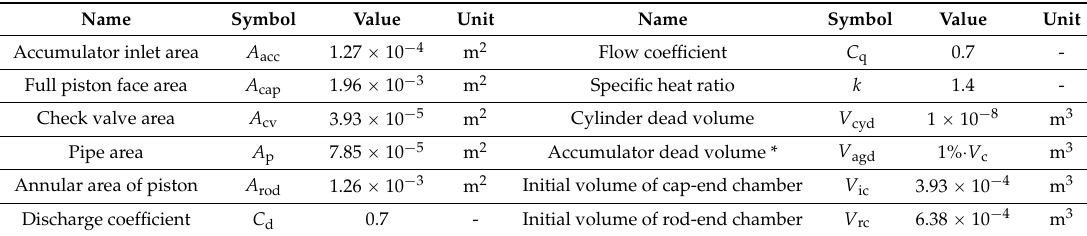
Table 2. Hydraulic parameters used in modelling.